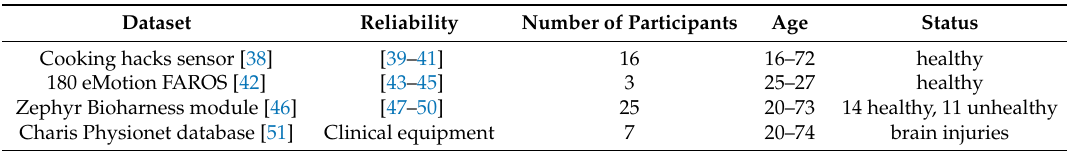
Table 1. Datasets summary information.